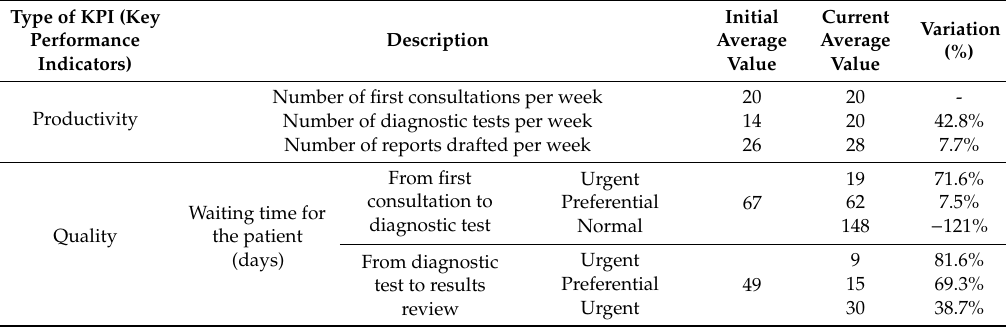
Table 4. Some of the KPIS defined in the case study with their initial and current average